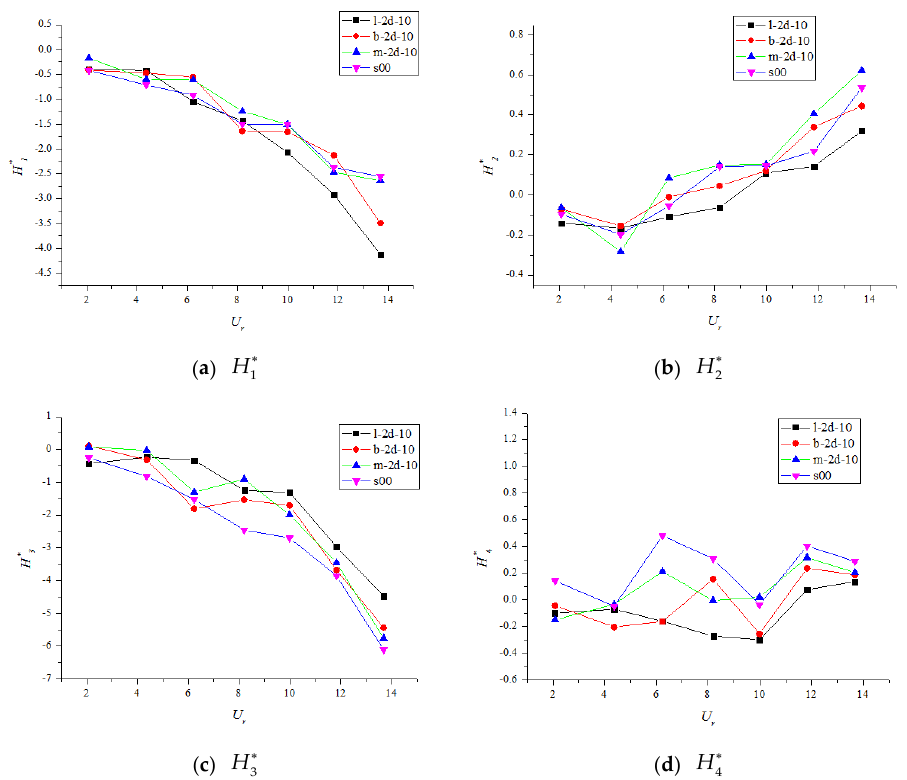
Figure 5. ( a – d ) Flutter derivatives H ∗